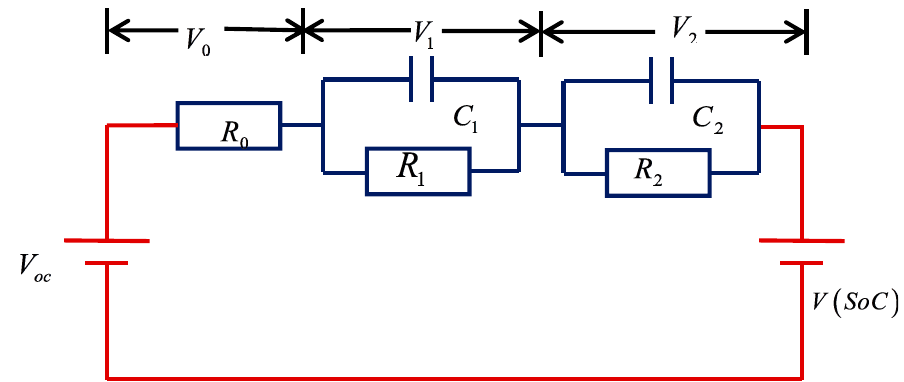
Figure 3. Battery equivalent circuit model with the double RC network.